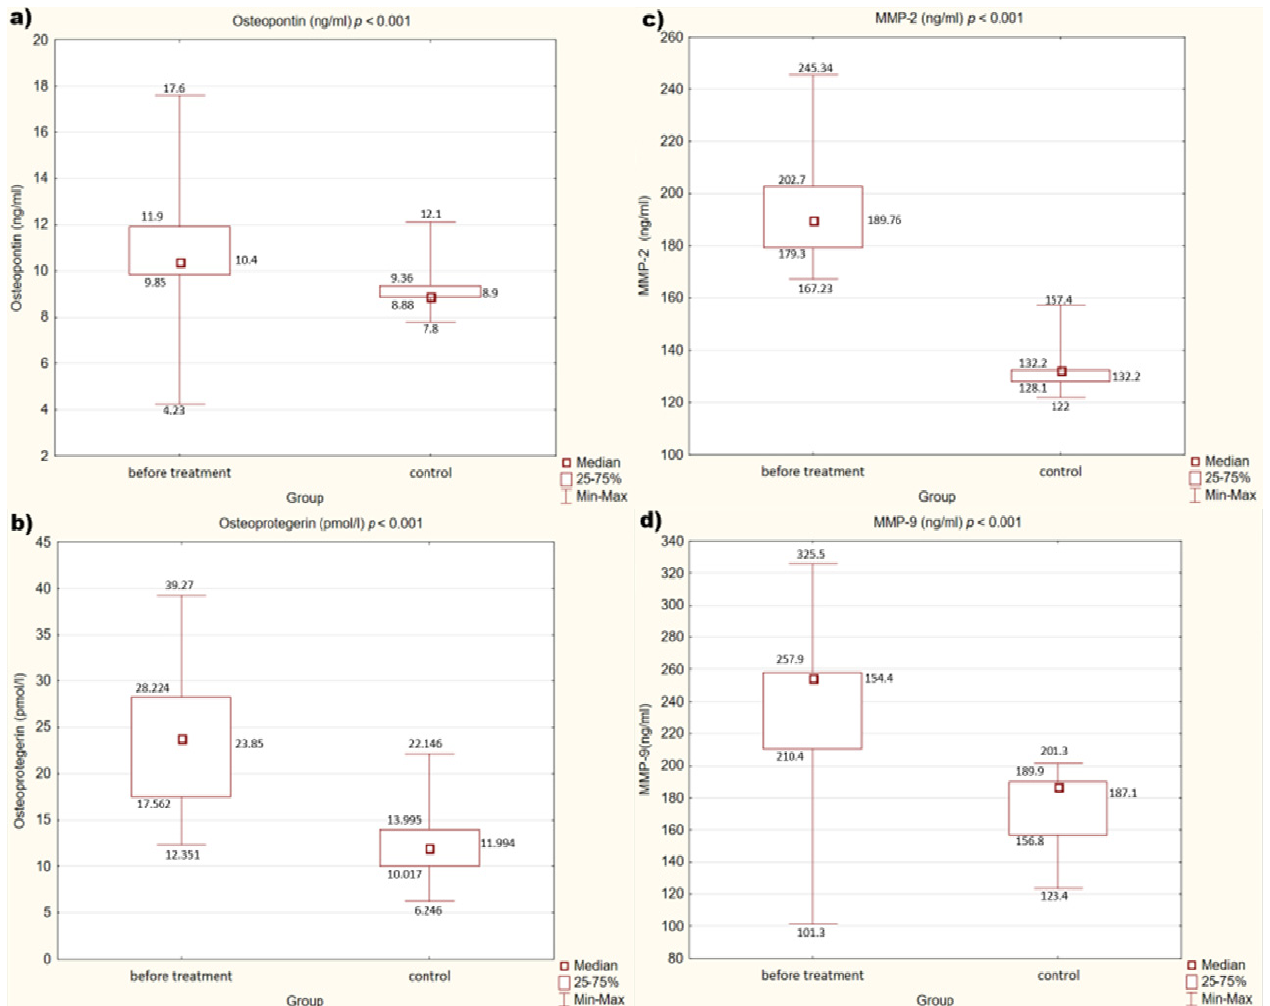
Figure 1. ( a – d ) Concentration of factors studied in the study and control groups. ( a ) Concentration of osteopontin (OPN) in study and control groups. ( b ) Concentration of osteoprotegerin (OPG) in study and control groups. ( c ) Concentration of metalloproteinase 2 (MMP-2) in study and control groups. ( d ) Concentration of metalloproteinase 9 (MMP-9) in study and control groups.